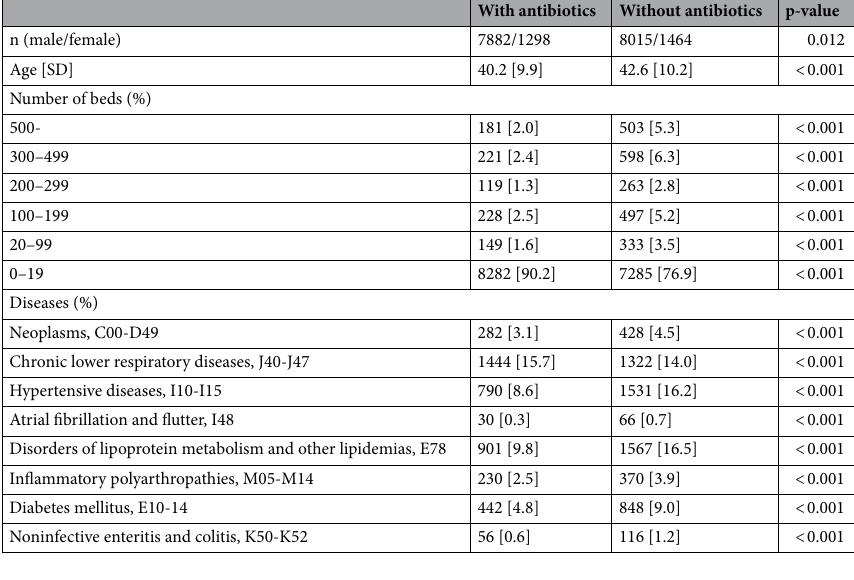
Table 1. Patients’